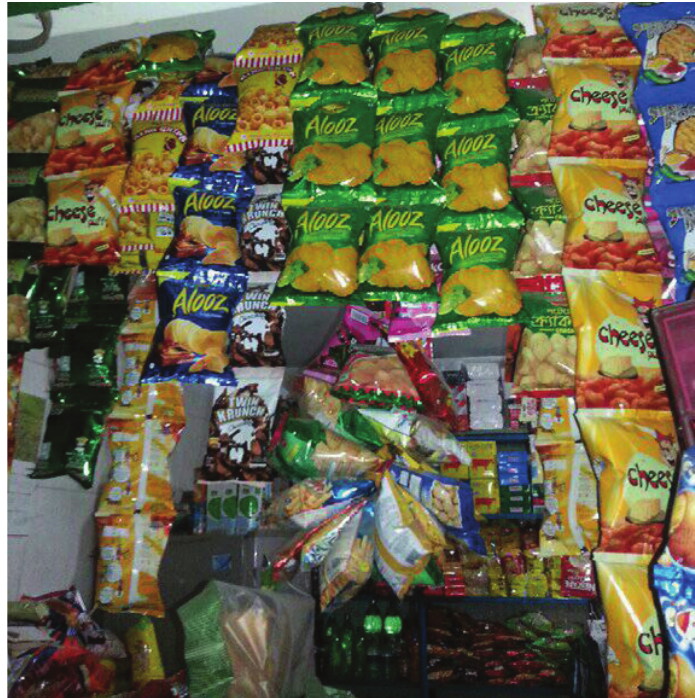
Figure 6. This photo was taken from a grocery shop nearby a high school in Dhaka city. The picture shows that a variety of junk foods are made available to school students. Most of these products are sold at extremely cheap prices (> $0.15). Photo credit: Sharmistha